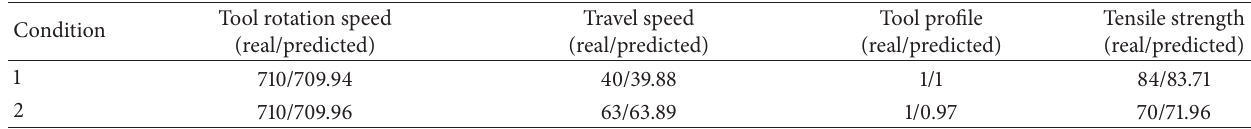
Table 4: Parameters calculated versus